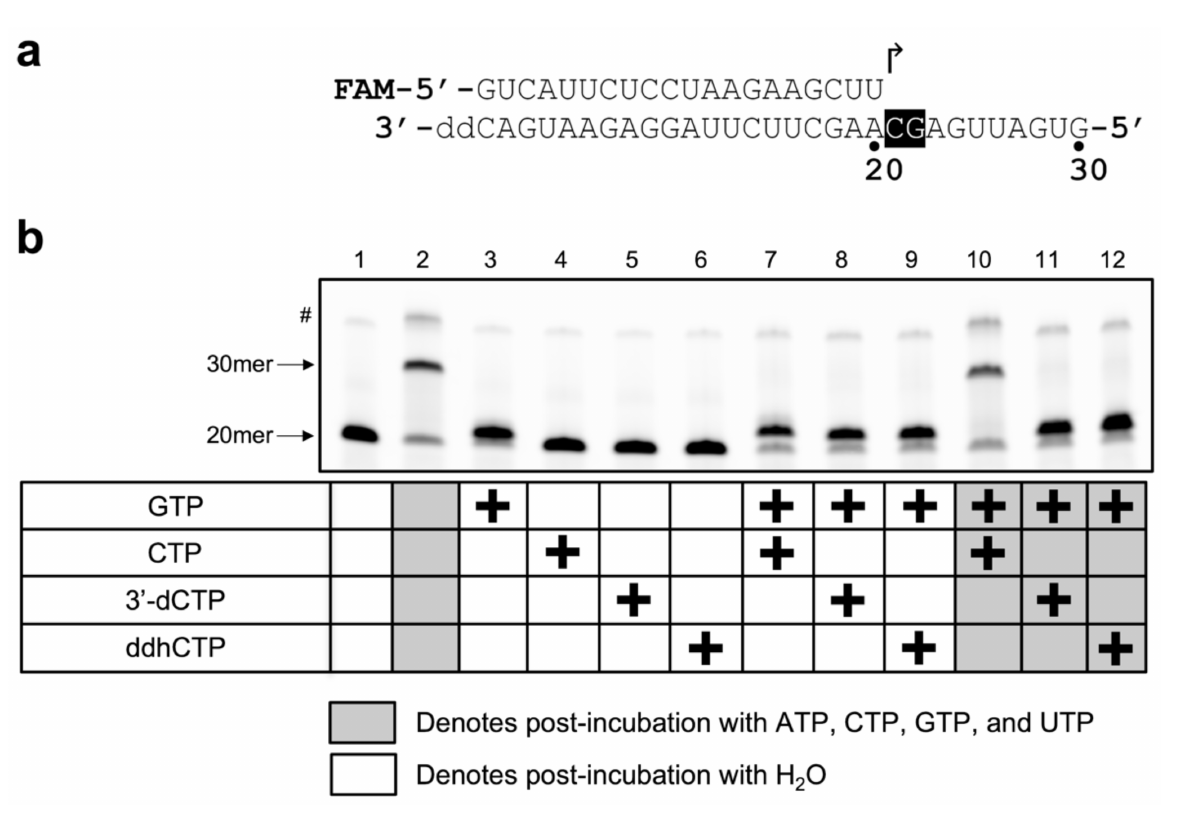
Figure 2. Incorporation of 3 (cid:48) -dCTP or ddhCTP by SARS-CoV-2 RdRp. ( a ) Sequences of the 5 (cid:48) - fluorescein-labeled 20-nt RNA primer and the 3 (cid:48) -protected 30-nt RNA template. ( b ) Products of primer extension by RdRp in the presence of the nucleotides indicated by “+” during the first incubation, followed by re-extension in the presence (shaded columns) or absence (non-shaded columns) of all NTPs. Whereas the product stalled after CTP incorporation (lane 7) is readily re- extended into the 30-nt product (lane 10), those stalled after 3 (cid:48) -dCTP or ddhCTP incorporation are chain-terminated and therefore could not be re-extended (lanes 11 and 12). Residual double-stranded form of RNA is denoted by #. A representative gel result for 3 independent experiments is